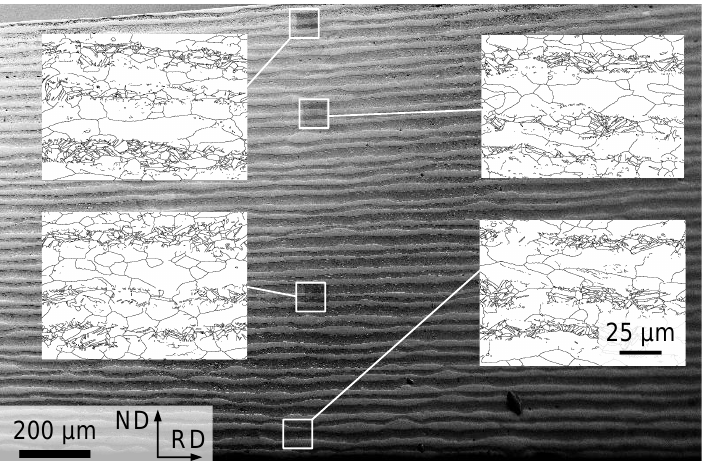
Figure 9. SEM micrograph showing the microstructure of a 160-layered Ti/Al composite obtained from six ARB cycles and subsequent conventional rolling (three passes). The inserts show grain boundary maps that have been evaluated from EBSD measurements at the depicted positions. Lines indicate high angle grain boundaries including twin boundaries.